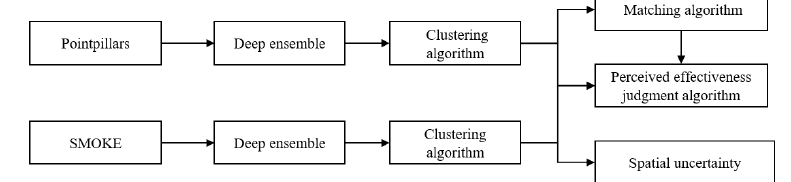
Figure 2. The logic flow between different